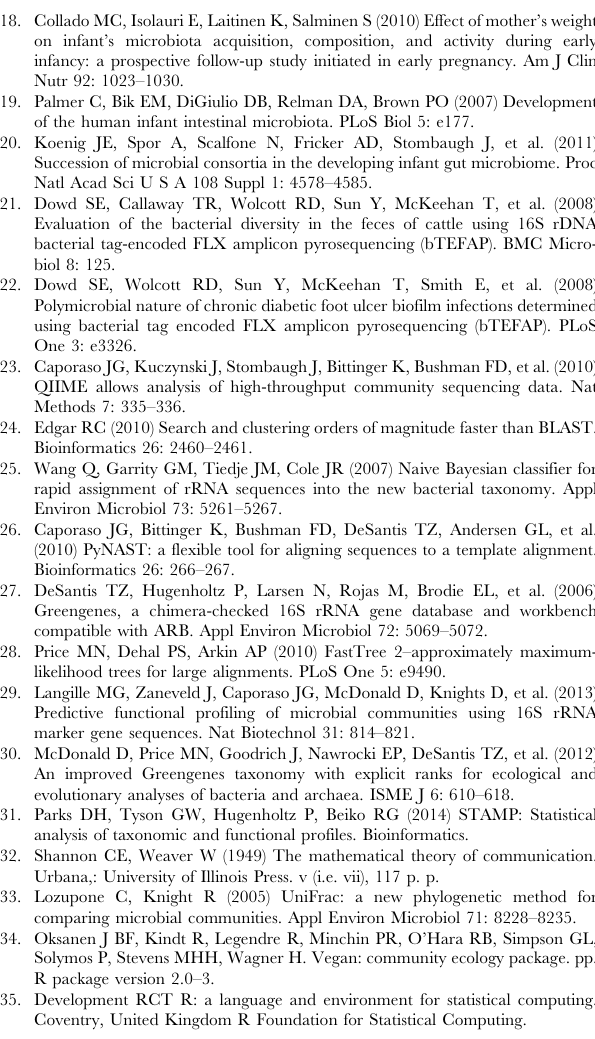
Figure S2 Other key factors which may impact the gut microbiome were not associated with differences in community structure, including (A) birth route (B) antibiotic use by the mother while breastfeeding (C) antibiotic use during pregnancy (D), child antibiotic use or (E) duration of breastfeeding. Figure S3 KEGG Orthologues (KOs) were highly similar across individuals. PiCRUST was used to predict metage- nomic function of the child microbiome. An area graph produced by QIIME indicated that overall abundances of KOs were similar across samples. Table S1 Potential Impacts Upon the Offspring Micro- biota. Table S2 KEGG Orthologues.